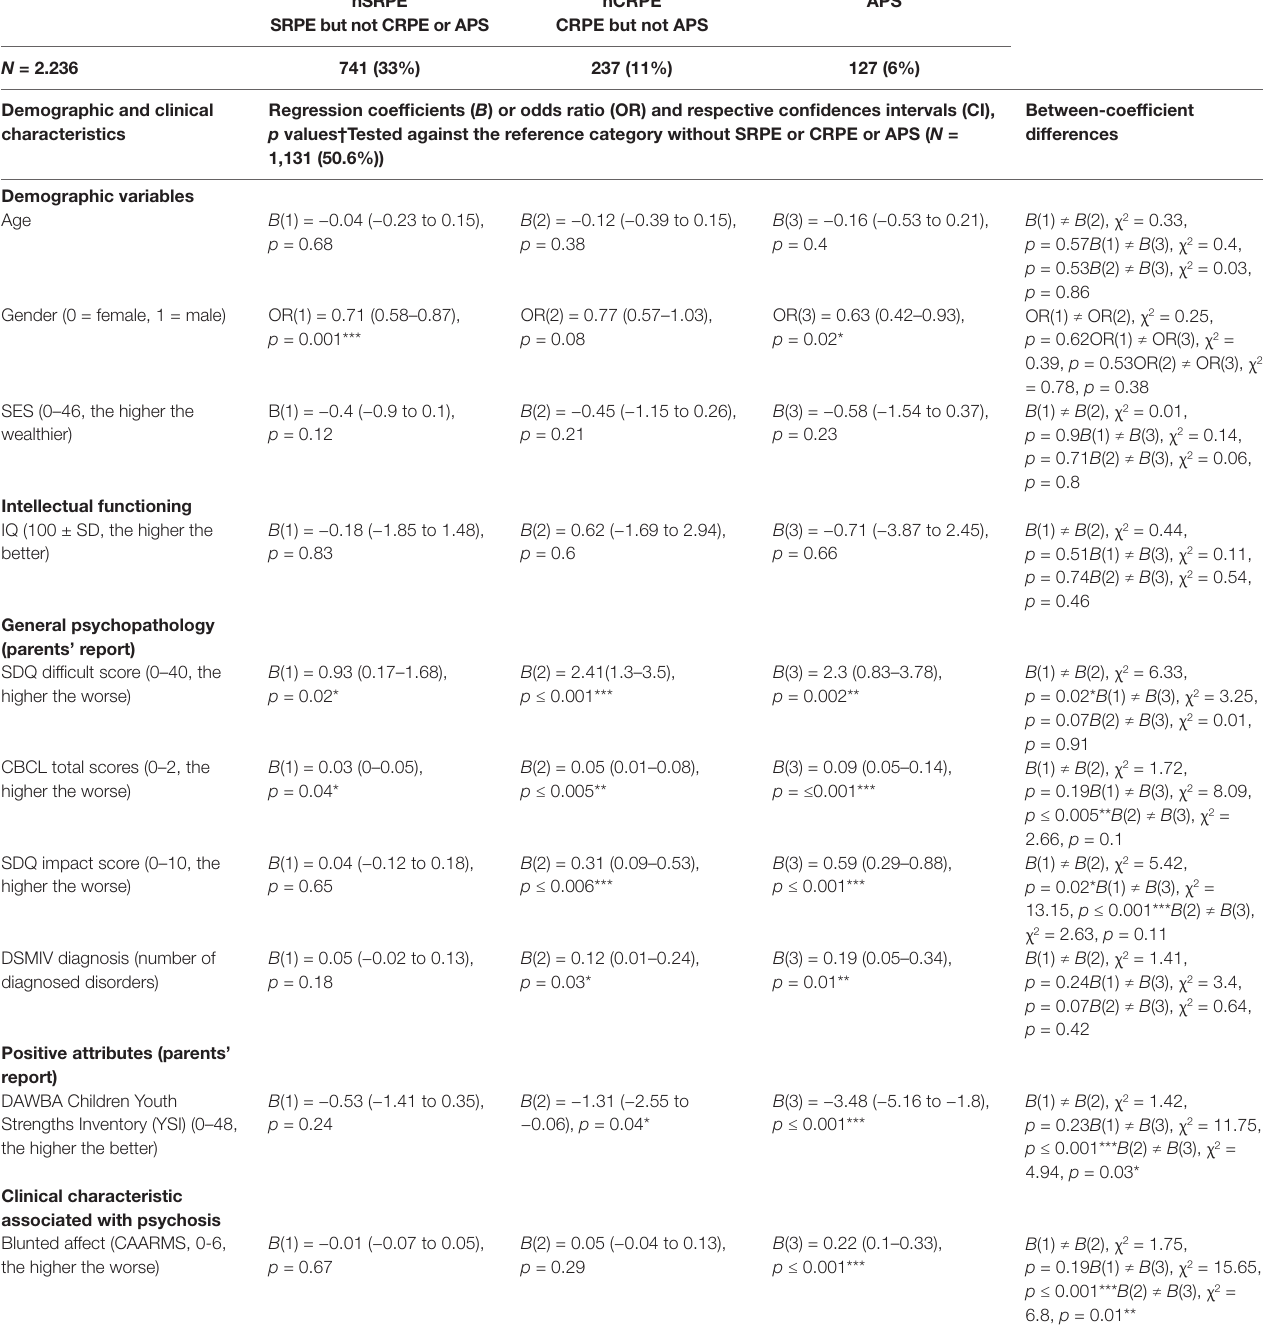
† Modelled according to sample structure: multilevel regression models, with clinicians and schools as levels and state as a confounder. Models were adjusted for age, gender, SES, and IQ *p ≤ 0.05; **p ≤ 0.01; ***p ≤ 0.001 PE and CAARMS were evaluated by psychologists and IQ was tested by psychologists using WISC. All other measures rely on parents’